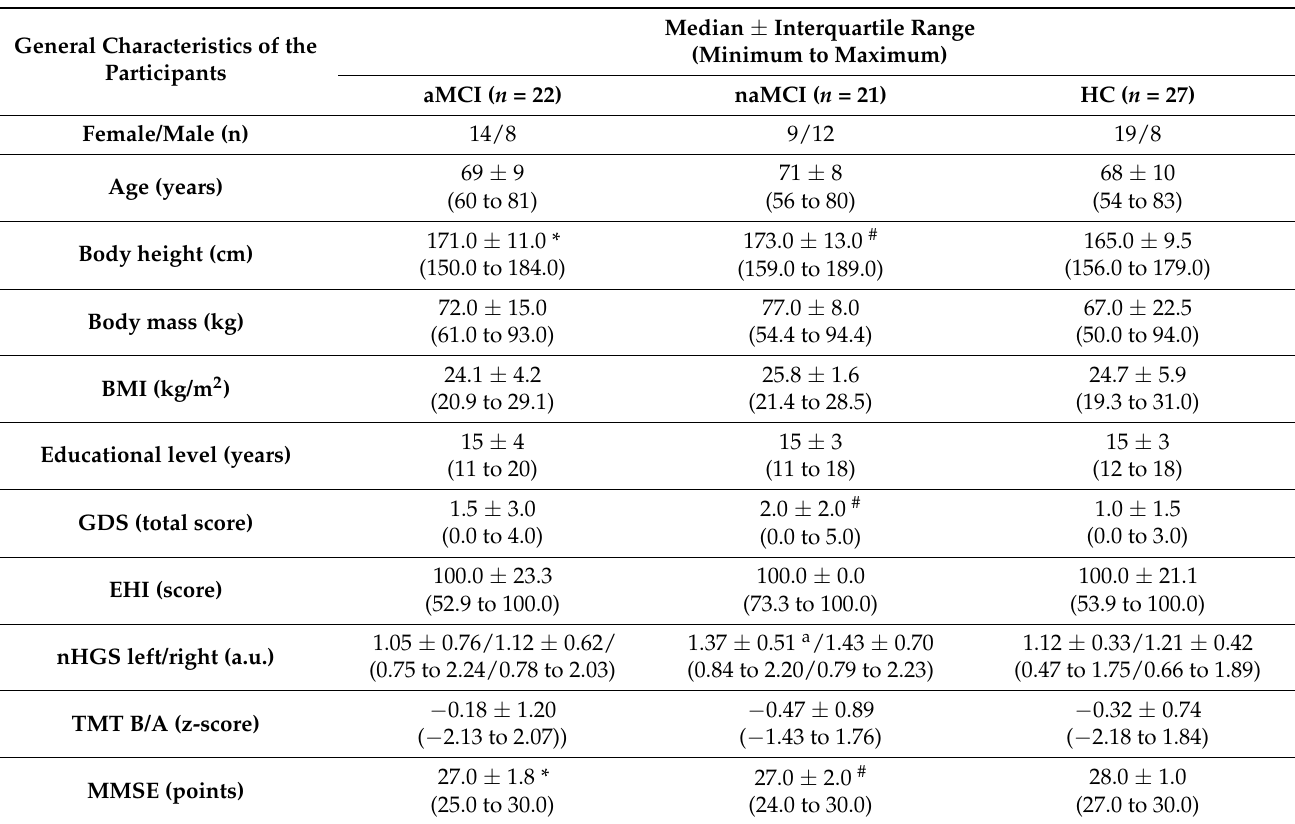
Table 1. Overview of the general characteristics of the